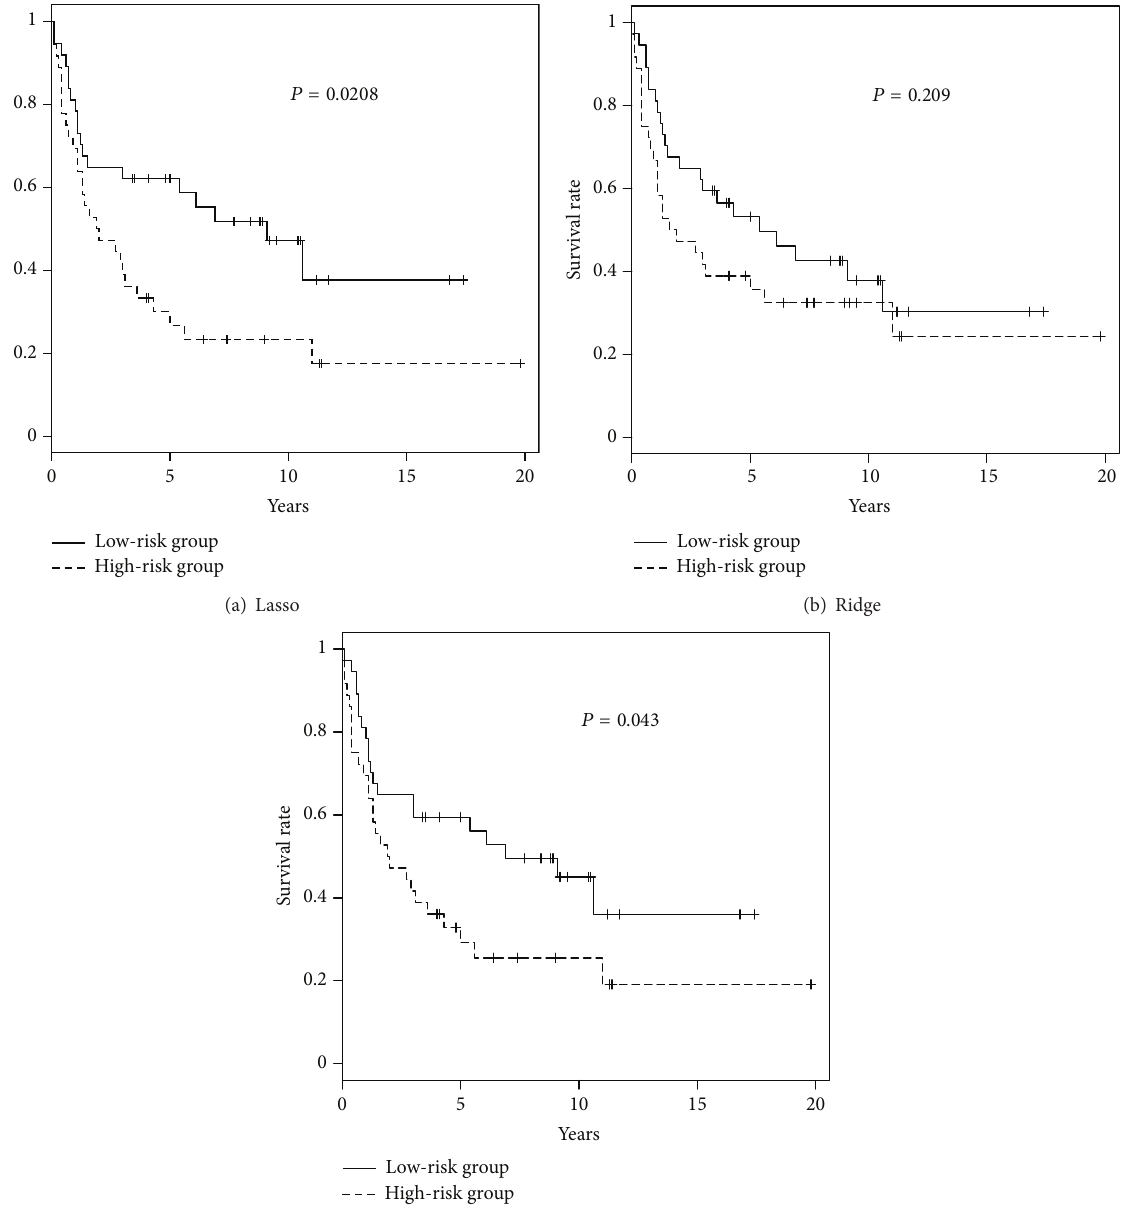
Figure 4: The Kaplan-Meier curve results of three penalized regression models, lasso, ridge, and elastic net, for low- and high- risk groups, respectively, after preselection of